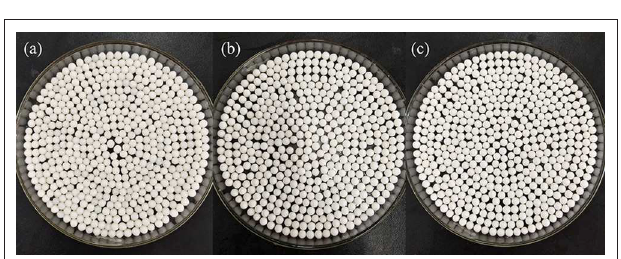
FIGURE 1 | Optical photos of CS/ZIF-8 composite beads with different content of ZIF-8 (A) CS/ZIF-8–36%; (B) CS/ZIF-8–51%; (C)